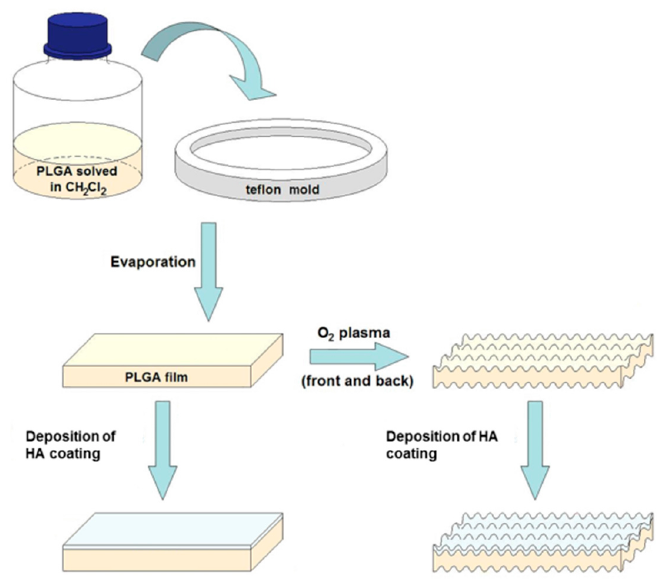
Figure 1. Manufacturing process of Poly(lactic– co –glycolic) PLGA membranes and subsequent surface treatment and deposition of thin layers of hydroxyapatite.